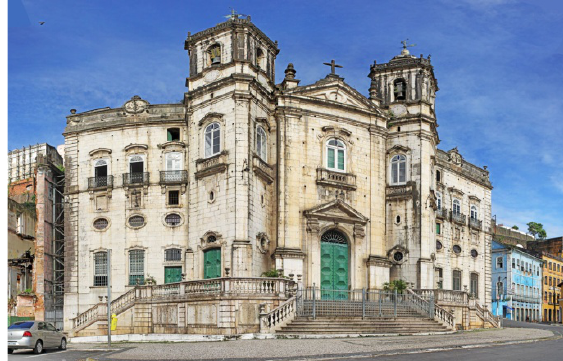
Figure 2. Example of outdoor spherical panorama: Igreja de Nossa Senhora da Conceição da Praia, Bahia.